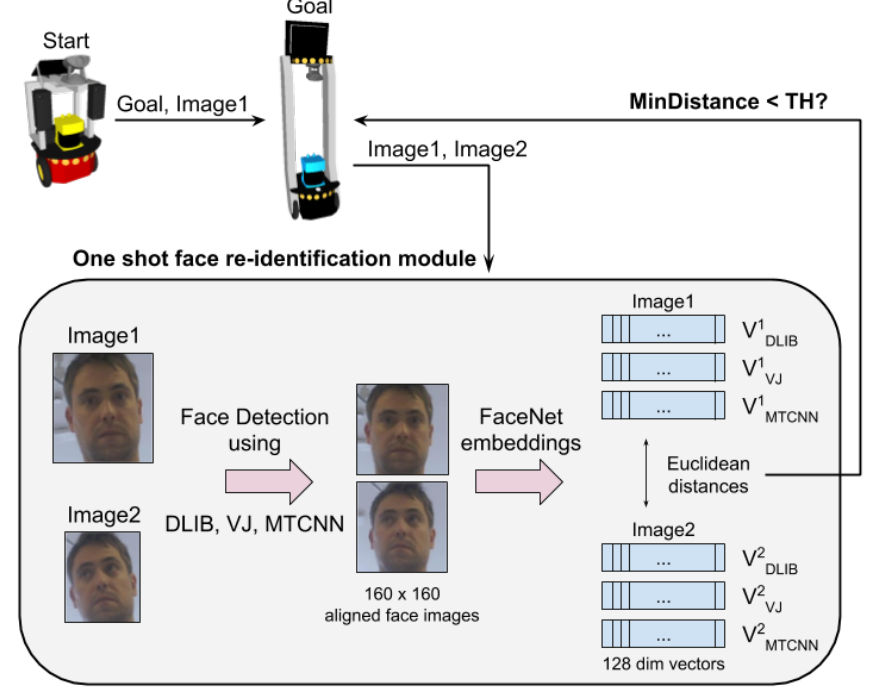
Figure 11. One-shot re-identification architecture in